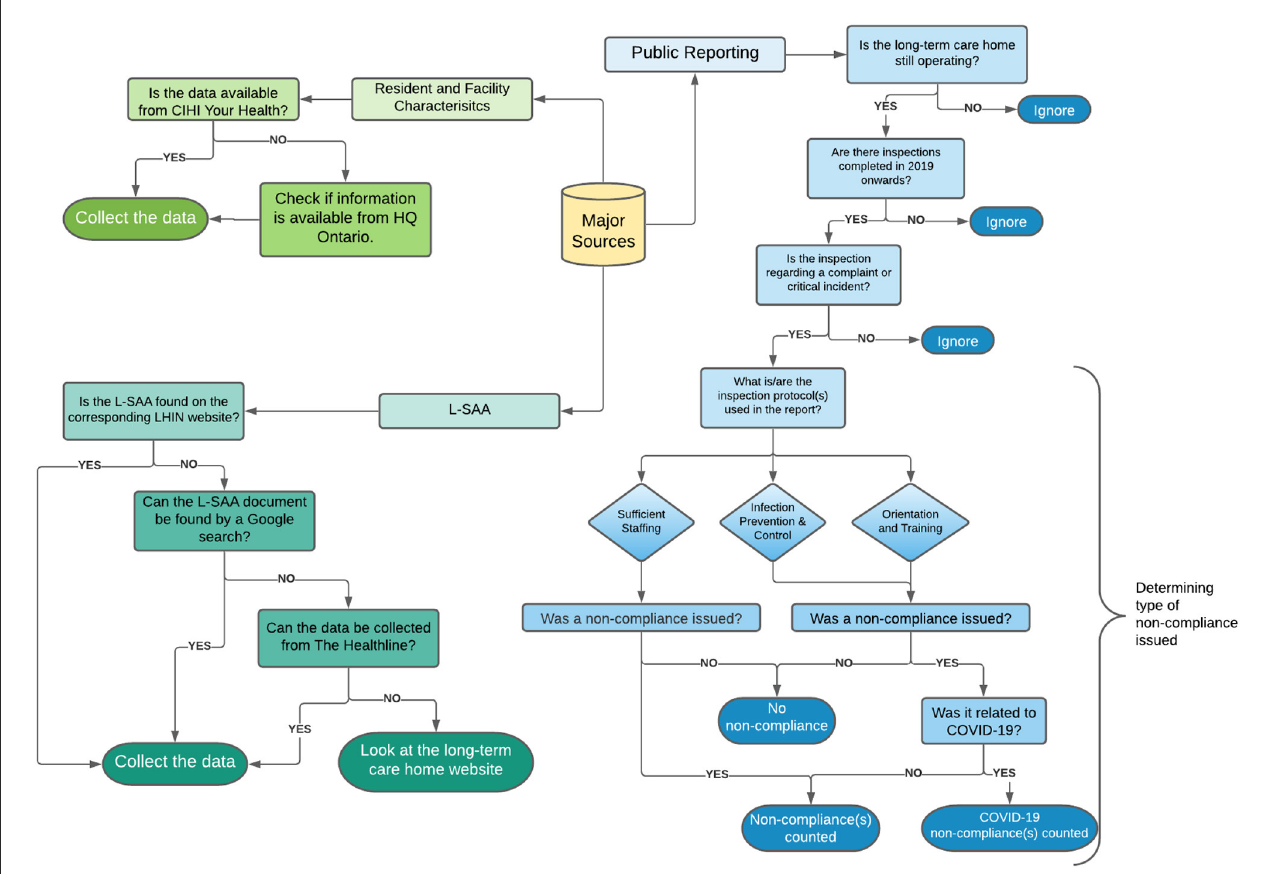
FIGURE1 Overview of data collection process. The flow-chart pictorially represents the process by which data sources were identified, collated and compiled within a single, comprehensive manually curated and validated database. The Public Reporting steps correspond to the website titled “Reports on Long-Term Care Homes” which is maintained by the Ministry of Health and Long-Term Care. The process outlined describes the classification of each report as it pertains to sufficient staffing (SS), Infection Prevention and Control (IPAC), and Orientation and Training (OAT). Data from the Long-Term Care Home Service Accountability Agreements (L-SAA) was collected from the Local Health Integration Network (LHIN) website, by a Google search, The Healthline, or the individual website of the home. Data pertaining to resident and facility characteristics were collected through CIHI Your Health system and HQ